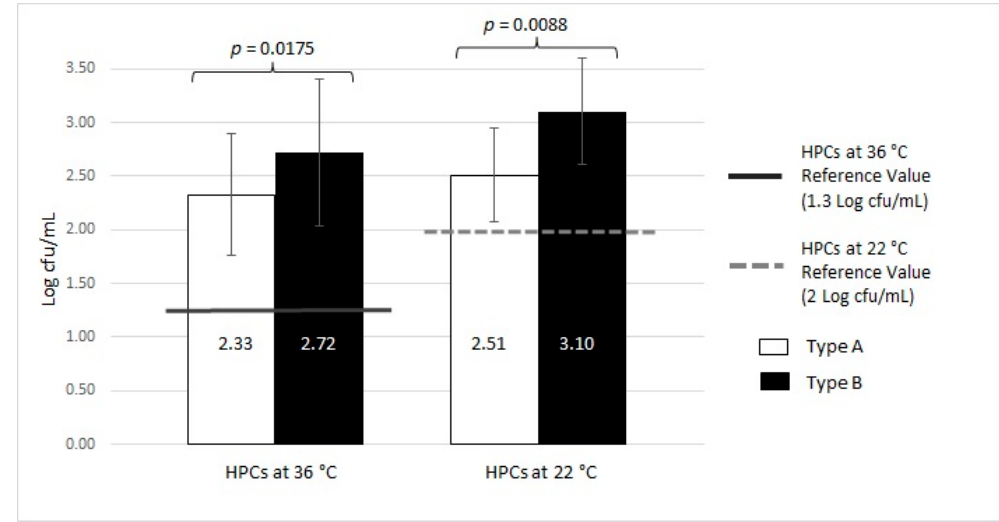
Figure 6. Microbiological contamination of total Type A and total Type B samples (MWDs): analysis of HPCs at 36 °C and 22°C.